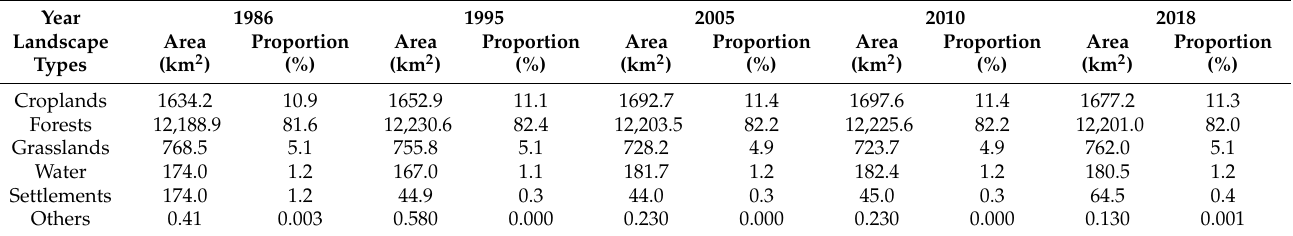
Figure 1. Study area. ( a ) Location of ecological red lines (ERLs) in the upper reaches of the Ganjiang River (UR-GJ, from the Jiangxi Provincial Government). ( b ) Monthly precipitation (1951–2020), monthly evaporation (1962–2019), and monthly average temperature (1951–2019) at Ganzhou meteorological station (from http://data.cma.cn accessed on 10 January 2020). Table 2. Area and proportion of each landscape type from 1986 to